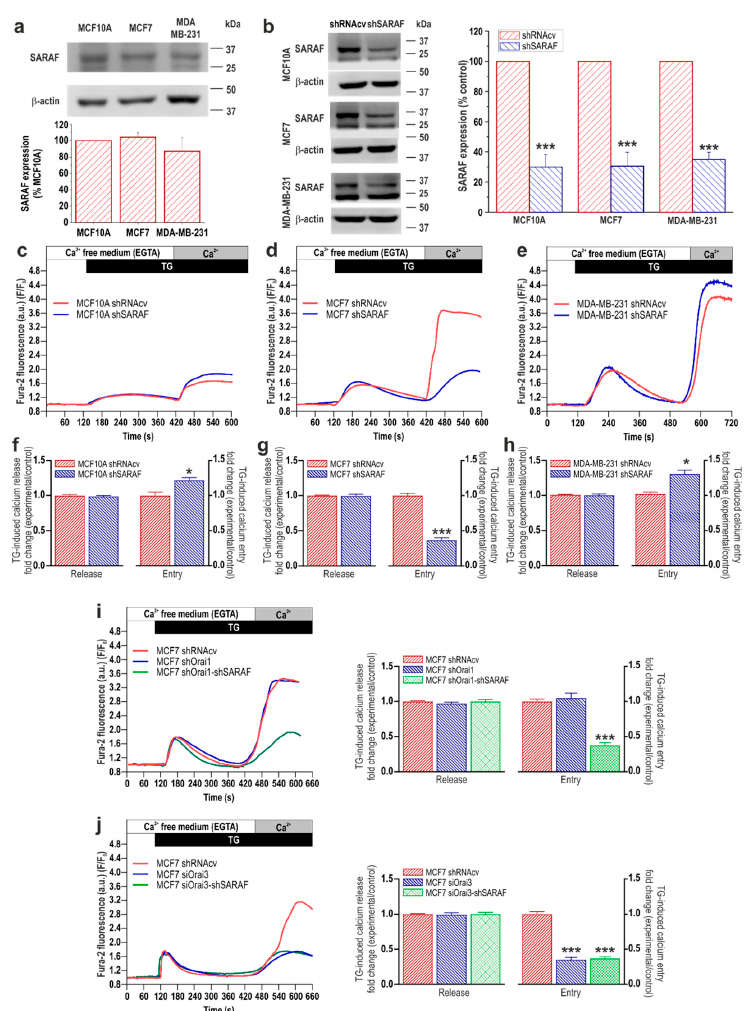
Figure 2. SARAF expression and functional role in SOCE in breast cancer and pre-neoplastic cells. ( a ) MCF10A, MCF7, and MDA-MB-231 cells were lysed and analyzed using Western blotting with a specific anti-SARAF antibody. The membrane was reprobed with an anti- β -actin antibody for protein loading control. Bar graphs represent SARAF expression normalized to the β -actin content and expressed as percentage of the expression in MCF10A cells. Molecular masses indicated on the right were determined using molecular-mass markers run in the same gel. ( b ) MCF10A, MCF7, and MDA-MB-231 cells were transfected with shSARAF or scramble plasmids (shRNAcv), as indicated. After 48 h cells were lysed and analyzed using Western blotting with an anti-SARAF antibody, followed by reprobing with an anti- β -actin antibody for protein loading control. Bar graphs represent SARAF expression normalized to the β -actin content at the different experimental conditions and expressed as percentage of the expression in shRNAcv-treated cells (control). *** p < 0.001 compared to SARAF expression in shRNAcv-treated cells. Uncropped Western blot figures in Figure S2. ( c – h ) MCF10A, MCF7. and MDA-MB-231 cells were transfected with shSARAF or scramble plasmids (shRNAcv), as indicated. Forty-eight hours after transfection, cells were loaded with fura-2 and perfused with a Ca 2+ -free medium (100 µ M of EGTA was added). Cells were then stimulated with TG (2 µ M) followed by reintroduction of external Ca 2+ (final concentration 1 mM) to initiate Ca 2+ entry. Bar graphs represent TG-induced Ca 2+ release and entry in MCF10A ( f ), MCF7 ( g ) and MDA-MB-231 ( h ), expressed as fold change experimental over control (shRNAcv-treated cells). Data are mean ± SEM of 40 cells/day/3–5 days. * p < 0.05 and *** p < 0.001 compared to Ca 2+ entry in control cells. ( i , j ) MCF7 cells were transfected with shOrai1 alone or in combination with shSARAF ( i ) or esiOrai3 alone or in combination with shSARAF ( j ) or scramble plasmids (shRNAcv), as indicated. Forty-eight hours after transfection, cells were loaded with fura-2 and perfused with a Ca 2+ -free medium (100 µ M EGTA added). Cells were then stimulated with TG (2 µ M) followed by reintroduction of external Ca 2+ (final concentration 1 mM) to initiate Ca 2+ entry. Bar graphs represent TG-induced Ca 2+ release and entry in MCF7 cells, expressed as fold change experimental over control (shRNAcv-treated cells). Data are mean ± SEM of 40 cells/day/3–5 days. *** p < 0.001 compared to Ca 2+ entry in control